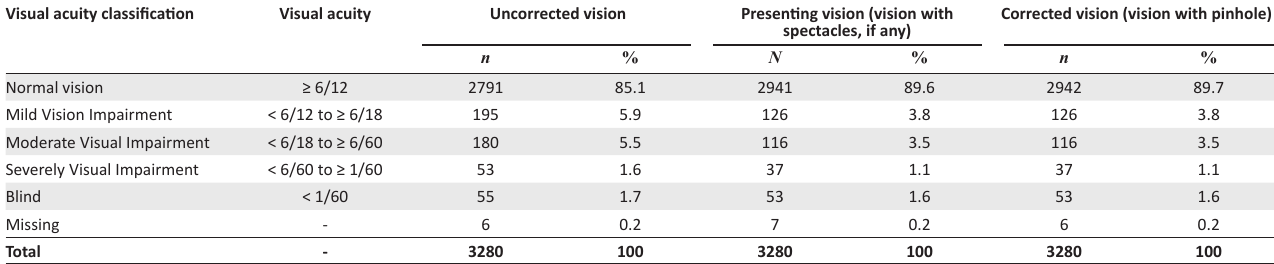
TABLE 2: Visual profile of the